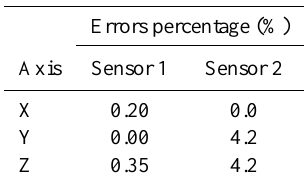
Table 13. Percentage of transmission errors during five